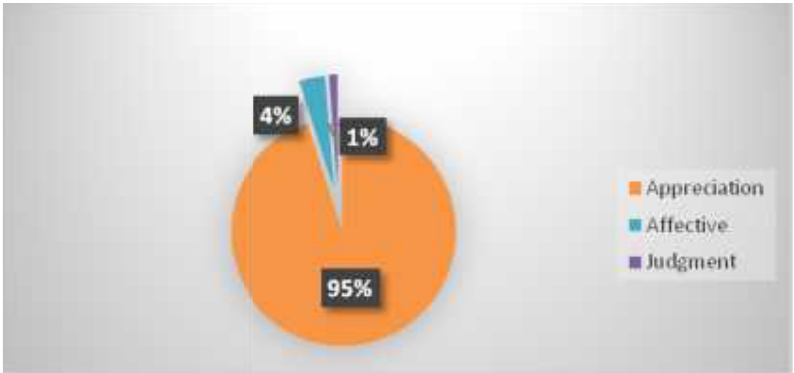
Figure 4.2 Pattern of Attitude of Hotel Homepages in Bali and Yogyakarta Discussion